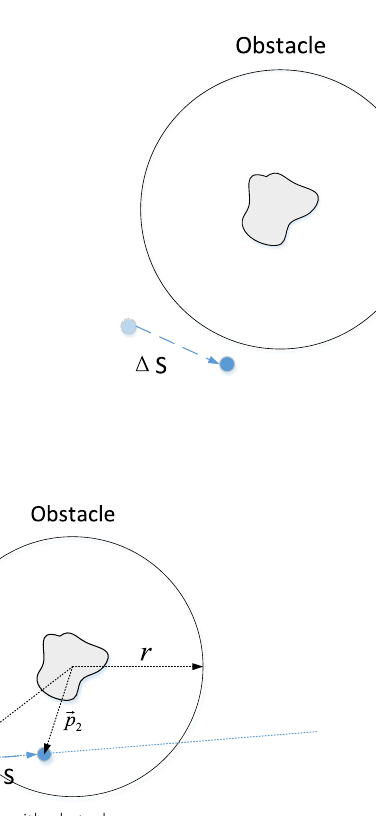
Fig. 11 Determine whether trajectory collides with